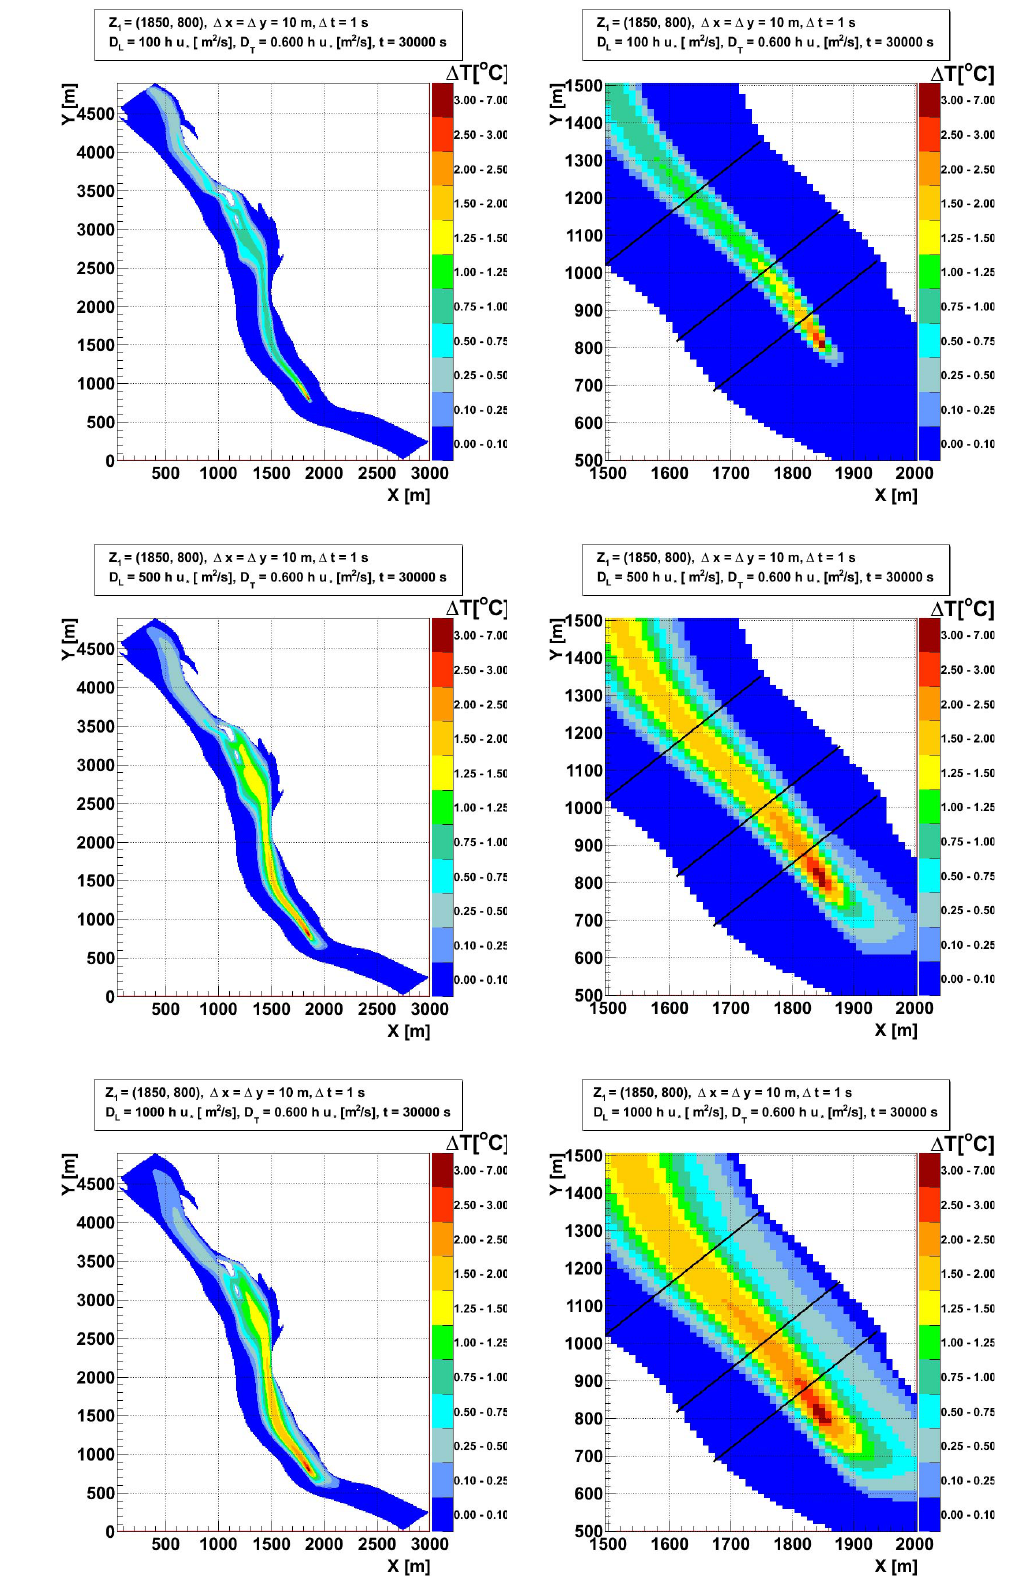
Fig. 6. Two-dimensional temperature distribution in case of continuous discharge of 14m 3 s − 1 of warm water at point Z 1 =(1850, 800) for different values of dimensionless coefficient a : 100 (top panels), 500 (middle panels) and 1000 (bottom panels).